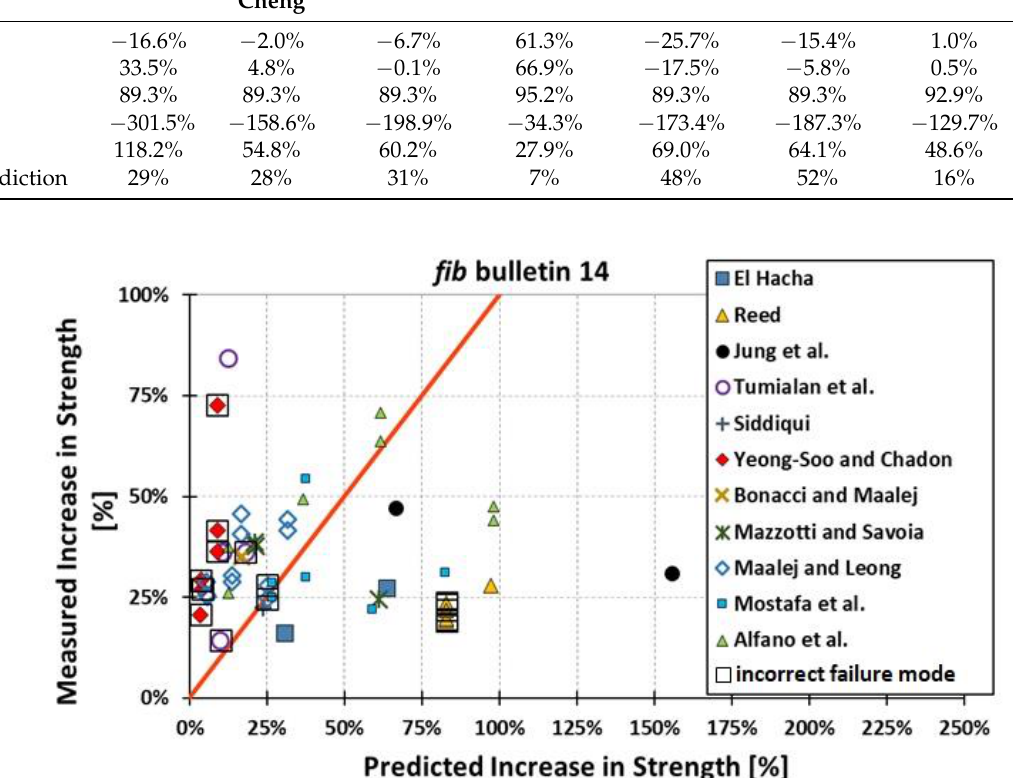
Figure 12. Measured increase in flexural strength versus fib bulletin 14 prediction.